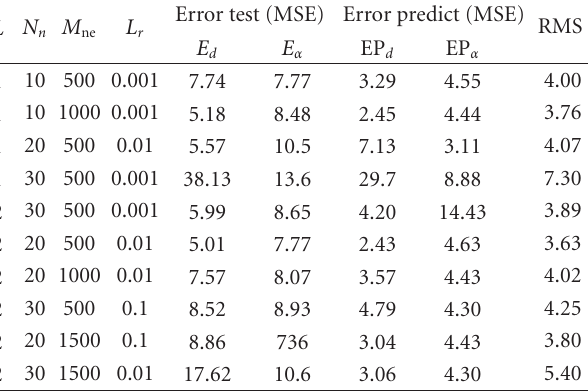
Table 3, the best network configuration with a minimum value of root mean square error RMS = 3 . 63 was